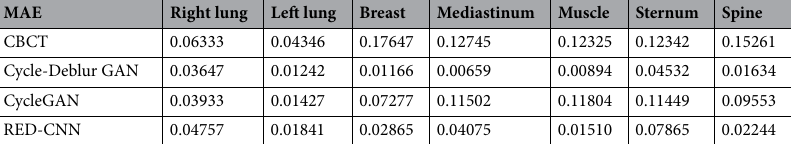
Table 2. MAE comparison of different models at different sites.